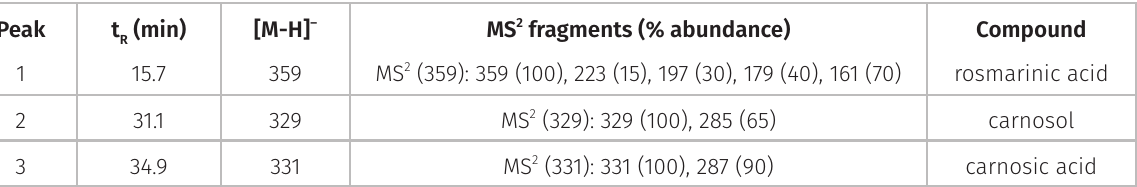
Table II. Peak number according to Figure 2, retention time (tR), [M-H] – ion, MSn fragments, and compounds identified from R. officinalis